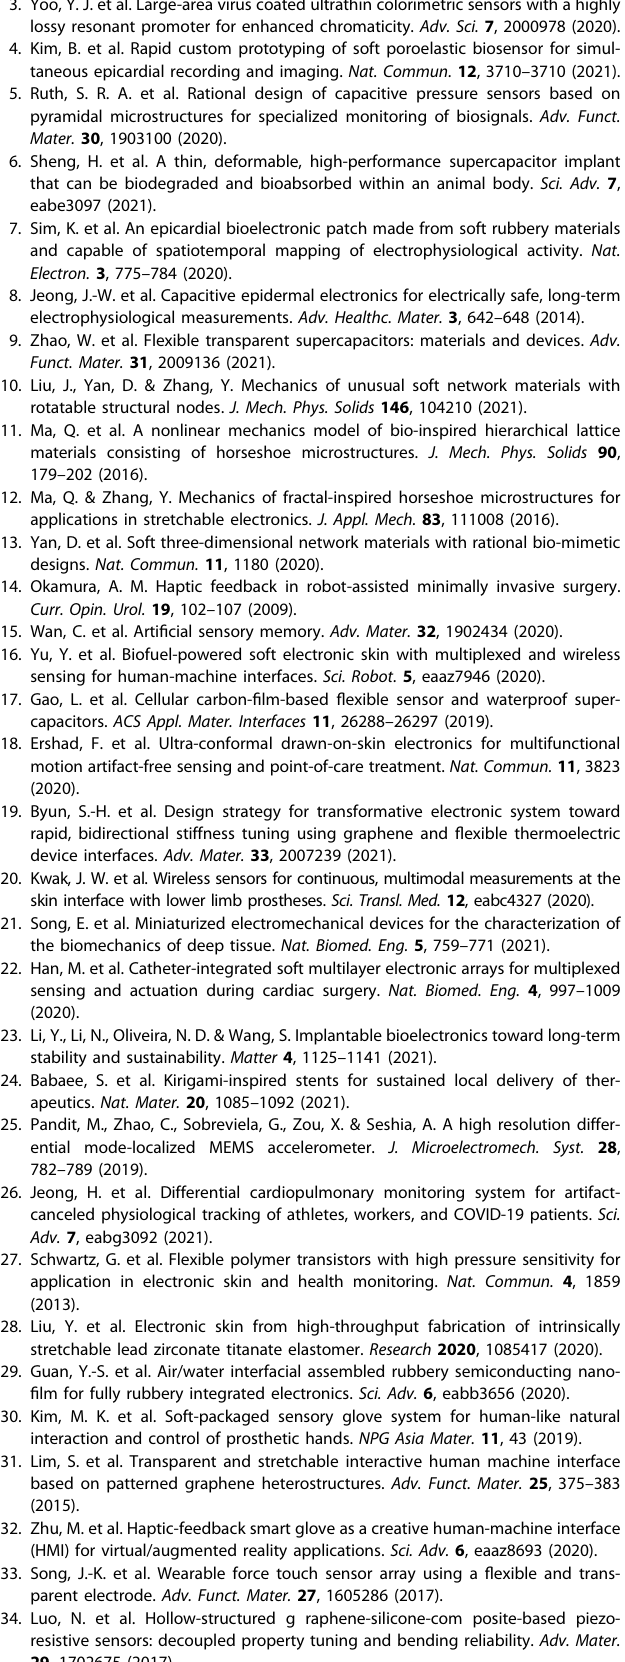
table devices. Sci. Adv. 5 , eaay0418 (2019). 59. Zhang, F., Fan, Z. & Zhang, Y. A theoretical model of postbuckling in